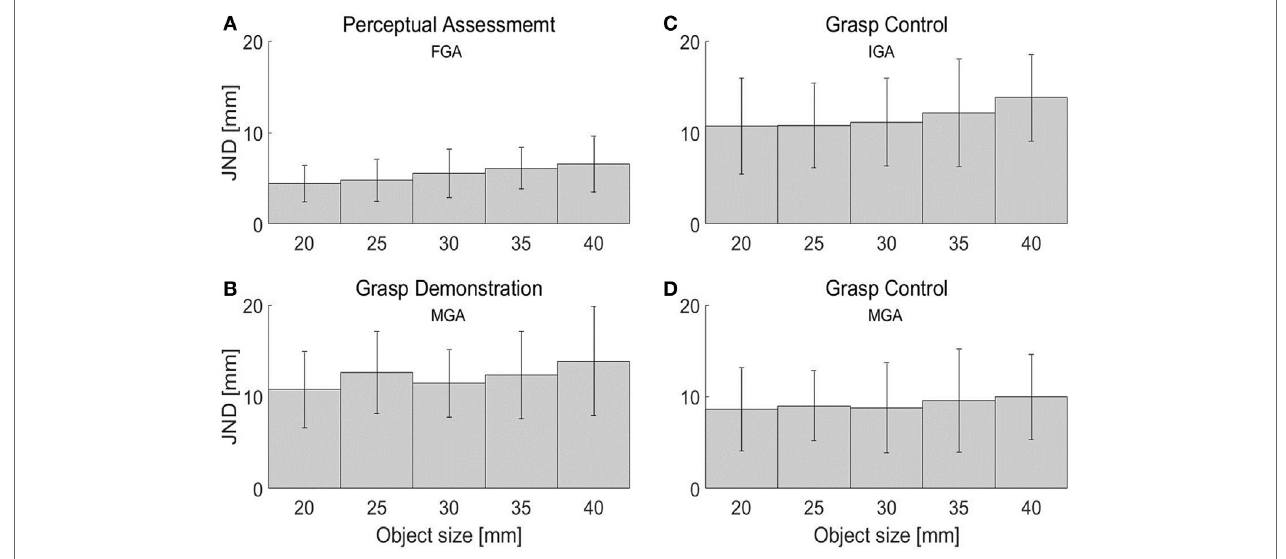
FigUre 6 | Mean of SD marked by crosshair. (a) final grip aperture (FGA), perceptual assessment. (B) maximum grip aperture (MGA), grasp demonstration. (c) initial grip aperture (IGA), grasp control. (D) MGA, grasp